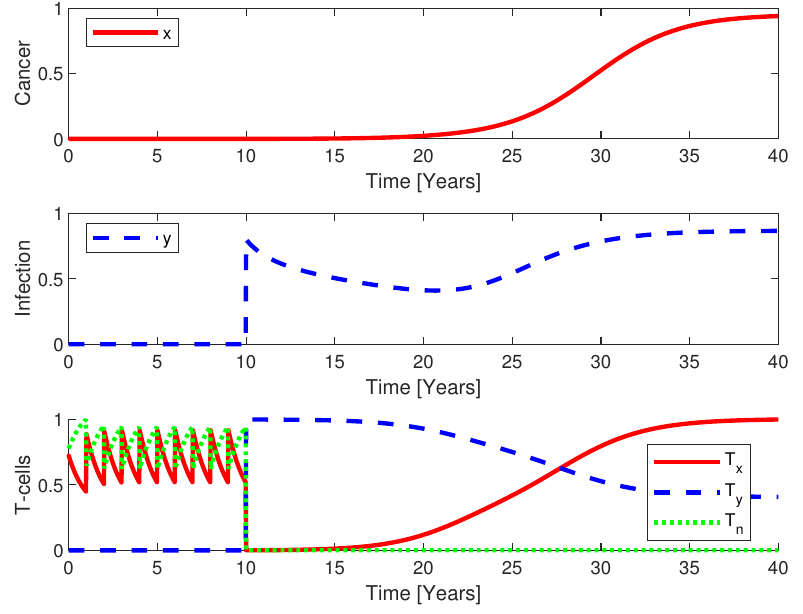
Figure 4. Despite an annual malignant mutation, the cancer is eradicated or kept in a dormant state (upper panel) for the first ten years by immunosurveillance in the absence of infection. At year 10, a severe infection is imposed (middle panel) and, thereafter, malignant mutation blooms into a cancerous clone capable of growing exponentially for a while whereas the development at the later stage is logistic (lower panel). This is caused by the infection taking resources from the immune system in fighting the malignant mutations. Whenever the cancer grows in size, it takes further resources from the immune system. Thus, the infection assists the cancer escape and whenever the immune system fails to eliminate the cancer, the infection grows too. This is a self-promoting spiral accelerating both the cancer progression and